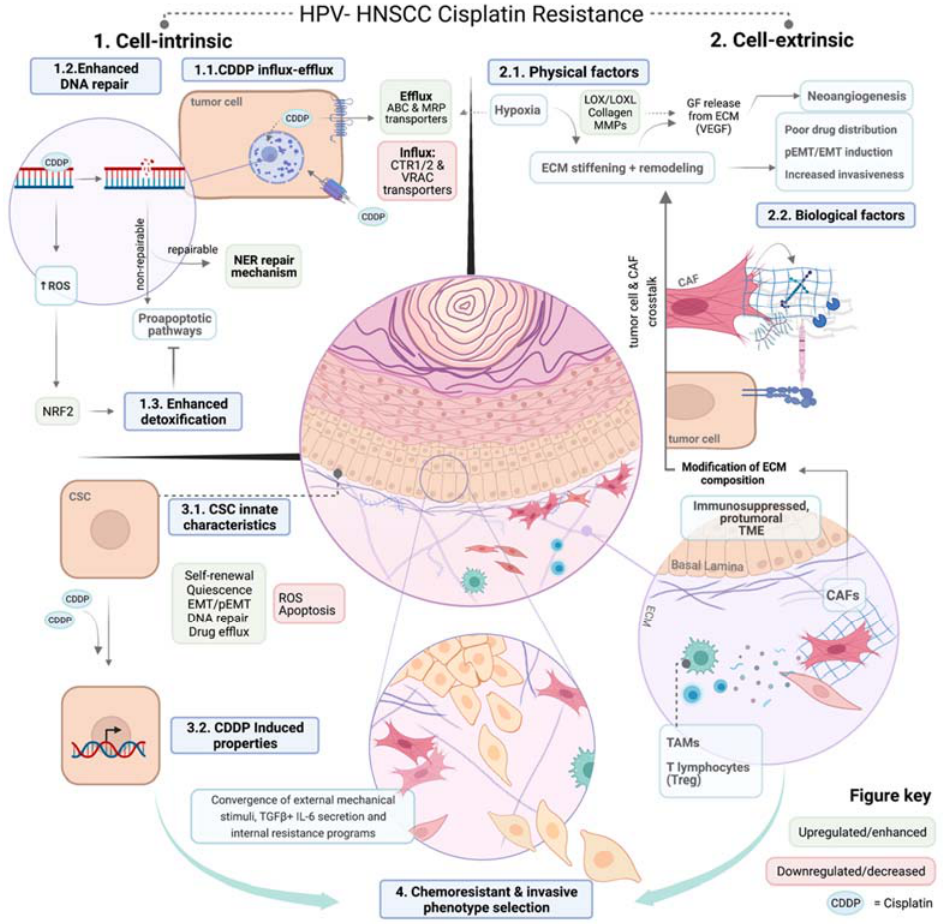
Figure 5. Cell ‐ intrinsic (1) and ‐ extrinsic (2) cisplatin resistance mechanisms converge to promote aggressive, invasive and chemoresistant phenotype selection in HPV ‐ negative HNSCC (4). Classic drug resistance mechanisms ((1), also in Figure 1) include efficient detoxification through deregulated transporter expression (1.1), enhanced NER DNA repair (1.2) and increased antioxidant mechanisms via the upregulation of NRF2 (1.3). CSCs displaying this innate chemoresistant behavior ((3.1), also in Figure 2C) may additionally intensify or boost these properties in response to cisplatin treatment (3.2), contributing to resistant clone selection which proliferates and gives way to relapses ((4), also in Fig. 2B). Cell ‐ extrinsic factors (2) can be divided into physical/mechanical factors (2.1) and biological components of the TME (2.2). As tumors grow, shear pressure makes the distribution of chemotherapy inefficient and nutrient supply becomes insufficient, triggering hypoxia response programs, which include the upregulation of efflux transporters (1.1) and ECM remodeling compo ‐ nents (LOX/LOXL enzymes, collagens and MMPs), which cleave and restructure the ECM, releasing embedded factors such as VEGF, involved in neoangiogenesis. Other factors contributing to ECM remodeling are non ‐ tumoral cells within the TME (2.2), which establish an intricate crosstalk with the neighboring tumor. Important interactions include bidirectional TGF β and IL ‐ 6 feedback loops between tumoral and non ‐ tumoral populations (CAFs, TAMs and Tregs), which induce ECM pro ‐ tein deposition and stiffening (Fig. 4). This modifies the adhesive distribution within tumoral cells, increasing cell–ECM interactions and triggering mechanosensitive pathways. These ultimately pro ‐ mote EMT expression programs, favoring invasive and resistant behavior (4). Created with BioRen ‐ der.com. Author Contributions: Conceptualization: A.B.G., L.A. ‐ R., and A.S. ‐ P. Writing ‐ original draft prep ‐ aration A.B.G., L.A. ‐ R., B.C., J.L.C. ‐ C. and A.S. ‐ P. Writing ‐ review and editing A.B.G., L.A. ‐ R., and A.S. ‐ P. Funding acquisition A.S. ‐ P. Both authors contributed equally A.B.G. and L.A. ‐ R. All authors have read and agreed to the published version of the manuscript.